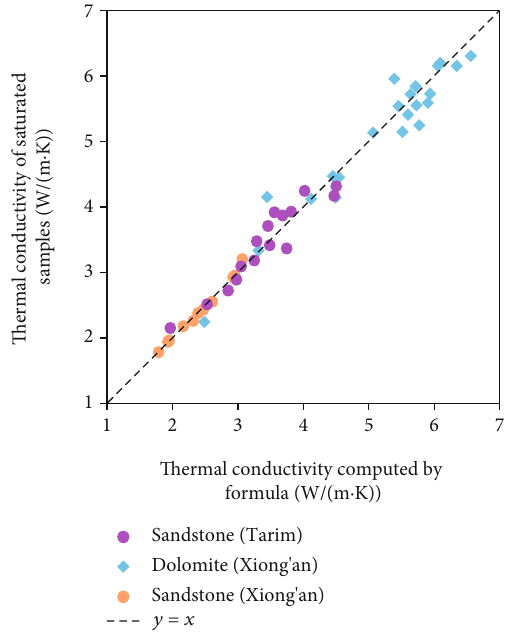
Figure 11: Comparison of thermal conductivity obtained by formula and experiment.